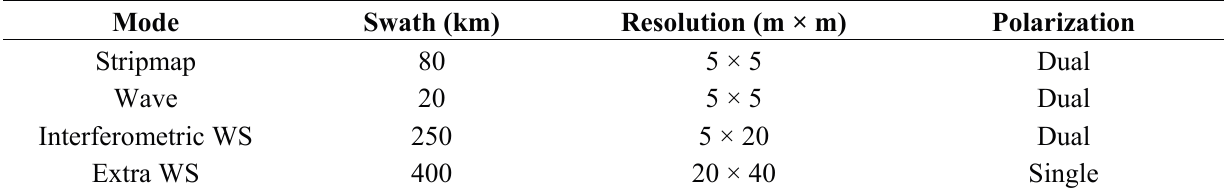
Table 1. Sentinel-1 operative